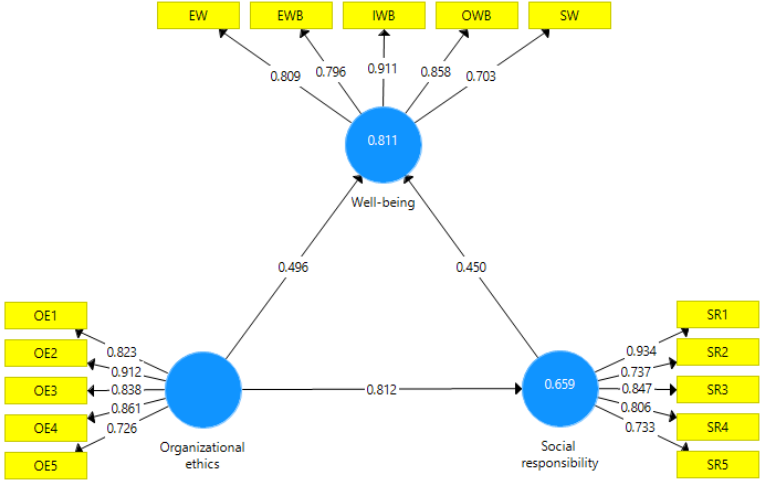
Figure 3. Preliminary model. Source: designed by authors using SmartPLS 3.0 (SmartPLS GmbH, Oststeinbek, Germany).